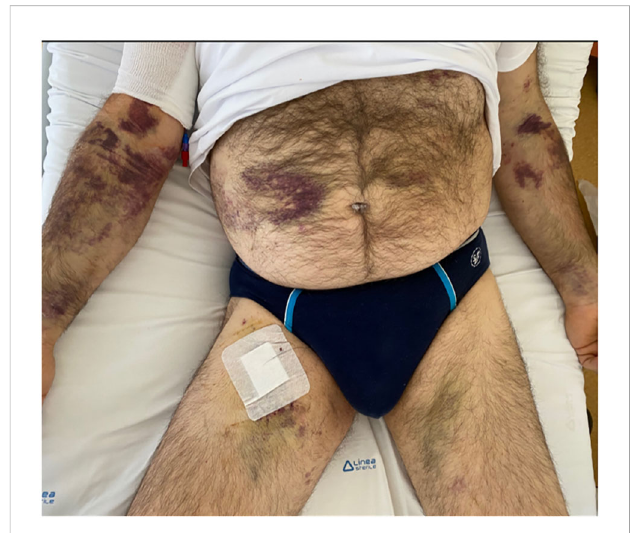
FIGURE 1 Cutaneous hematomas on oncology ward